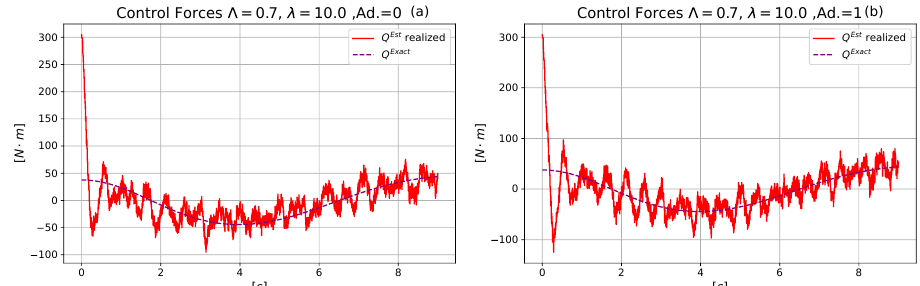
Figure 16. The control torque Q 1 for the small amplitude and circular frequency of the nominal trajectory. ( a ): Non-adaptive, ( b ): adaptive